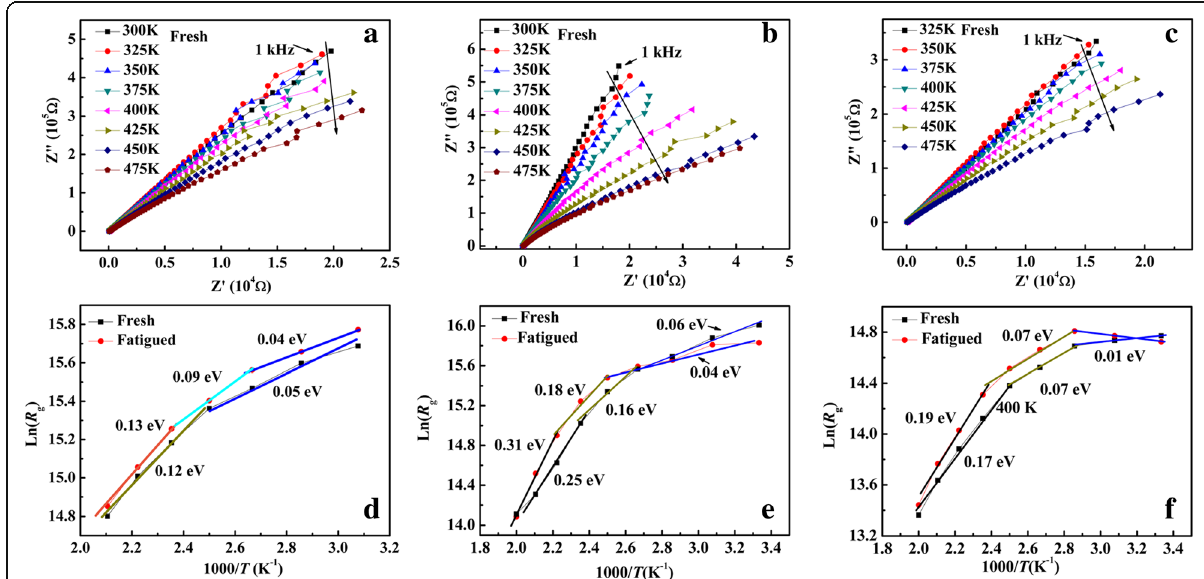
Fig. 5. Impedance diagrams at elevated temperature and Ln( R g ) vs 1000/ T Arrhenius plots at both fresh and fatigued condition: a , d for BNTM-1; b , e for BNTM-2; c , f for